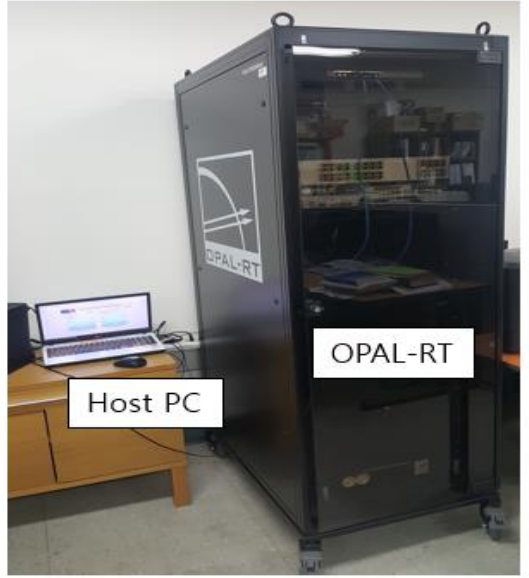
Figure 7. Experimental setup. Table 1. System parameters.